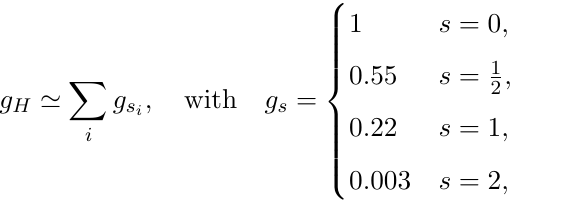
15 and + for (cid:27) = 3 : 42 (cid:2) 10 (cid:0) 10 (cid:0) 6 , (cid:2) ( k 2 ) 1 U(1) (cid:2) 10 7 (cid:28)